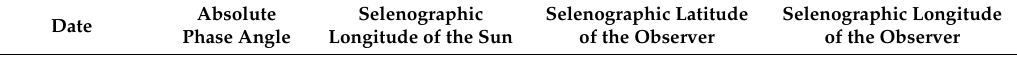
Table 2. Date of the observations and geometry.